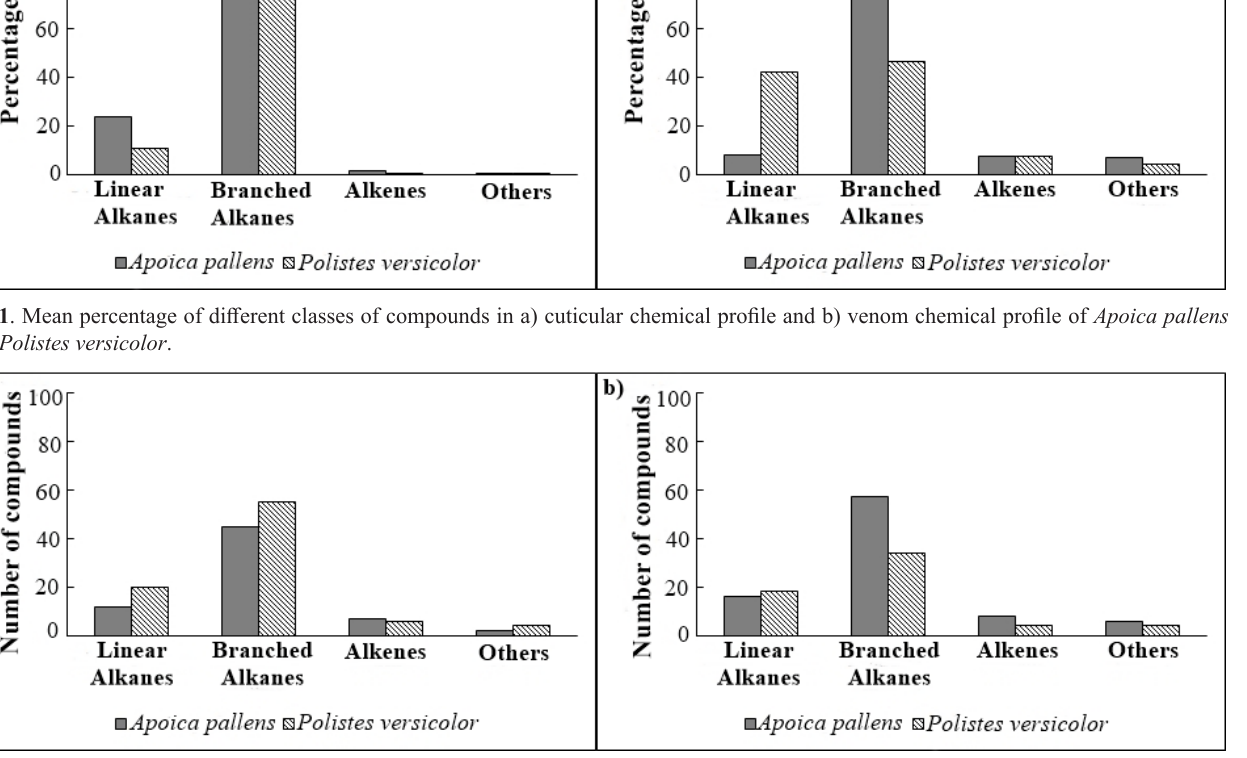
Fig 2 . Number of compounds of the different classes in a) cuticular chemical profile and b) venom chemical profile of Apoica pallens and Polistes